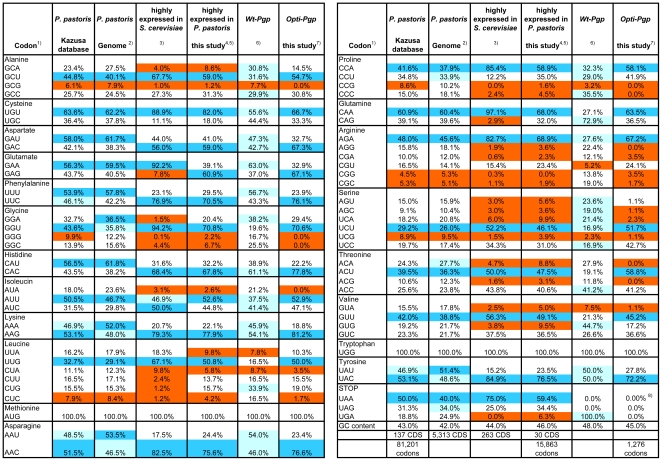
Comparison of codon usage.
1) Codons with low frequency (<10%) are highlighted in red. The most preferred codon for each amino acid is highlighted in dark blue. Most frequent codons (and second most frequent, if within 10% of the first) in WT-Pgp are highlighted in light blue. 2) From [23]. Five codons occur at low frequencies in the Kazusa and Genome databases, which do not discriminate between poorly and high expressed genes, e.g. the codons for Ala (GCG), Leu (CUC), Arg (CGG and CGC) and Ser (UGG). Some preferred codons differ between the Kazusa and the Pichia genome databases, namely the codons for Gly, Lys and Asn; this is likely due to the limited number of 137 CDS's represented in the former. 3) From [15]. 4) The codon usage analysis was updated March 2011 to include the 30 most highly expressed genes in P. pastoris (see Table S1) based on proteome analysis [26], [27], [28]. Incidentally, all 30 genes are also among the 100 most highly transcribed genes seen in microarrays (Mattanovich, unpublished observations). 5) In highly expressed genes, an additional 18 codons occur at low frequencies, e.g. the codons for Ala (GCA), Gly (GGG and GGC), Ile (AUA), Leu (CUA, CUC and UUA), Pro CCG and CCC), Arg (AGG and CGA), Ser (AGU, AGC and UCA), Thr (ACA and ACG) and Val (GUA and GUG). Comparison of the preferred codon between highly expressed Pichia genes and the Kazusa/genome databases revealed an inverted preference for the Asp codon AAC over AAU, CAC over CAU for His and UUC over UUU for Phe. There was also a strong preference for the Lys codon AAG over AAA, AAC over AAU for Asn, and UAC over UAU for Tyr among highly expressed Pichia genes. Notably, the codon choice for Glu differed between highly expressed genes of the two yeasts with S. cerevisiae showing a clear preference for GAA (92%) whereas P. pastoris has a more balanced distribution of 61:39% between GAA and GAG. 6) The native Pgp revealed extensive codon bias, with pronounced over-representation of codons occurring at low frequency among highly expressed Pichia genes; viz. codons used for Ala (GCG), Gly (GGG, and GGC), Ile (AUA), Leu (CUA and CUC), Pro (CCC and CCG), Arg (AGG, CGA, CGG and CGC), Ser (AGC, AGU, UCA and UCG), Thr (ACG), and Val (GUA). The native gene also under-represented the Pichia higher frequency codons including the preferred codons (compare dark and light blue in columns 4 and 5). For example, the three codons for Ala (GCA, GCU and GCC) are used at about equal frequencies (30–32%) in WT-Pgp whereas highly expressed Pichia genes show a clear preference for GCU (59%) over GCC (31%) and GCA (9%). 7) For gene optimization all low-frequency codons (<8%) were set to zero and the distribution of frequencies adjusted to those of highly expressed Pichia genes. In some cases, desirable restriction enzyme sites required the presence of a low-frequency codon. 8) The C-terminal His6-tag and STOP codons were provided by the pLIC-H6 vector (Fig. S2) and were CAT CAT CAT CAT CAT CAT TGA.